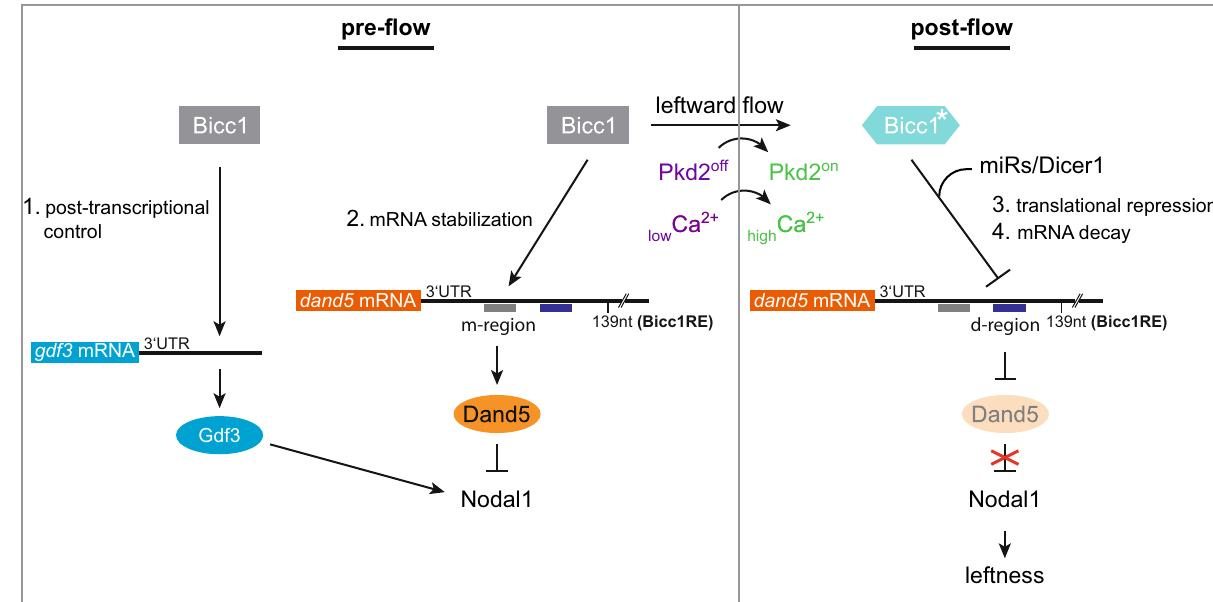
Fig. 8 Two modes of Bicc1-dependent post-transcriptional regulation of gdf3 and dand5 in fl ow sensor cells at the Xenopus left-right organizer. In the early neurula pre- fl ow stages, Bicc1 has two functions. Bicc1 assures gdf3 mRNA translation and thereby indirectly ensures nodal1 transcription by Gdf3 signaling. Simultaneously Bicc1 mediates dand5 mRNA stability via the medial (m) sub-region of the Bicc1RE. Thus, Dand5 protein levels are sustained on both sides, keeping Nodal in tight repression. Leftward fl ow activates the Pkd2 channel in left fl ow sensor cells, resulting in an asymmetric calcium signal. In post- fl ow stages, a calcium-dependent mechanism activates/modi fi es Bicc1 to become a repressor of dand5 translation, which is relayed by the distal (d) sub-region of the Bicc1RE. Subsequently, dand5 mRNA gets degraded in a Dicer1 (miR) dependent manner. Attenuated Dand5 expression lifts repression of Nodal and de fi nes leftness by induction of the LPM Nodal signaling cascade. For details, see